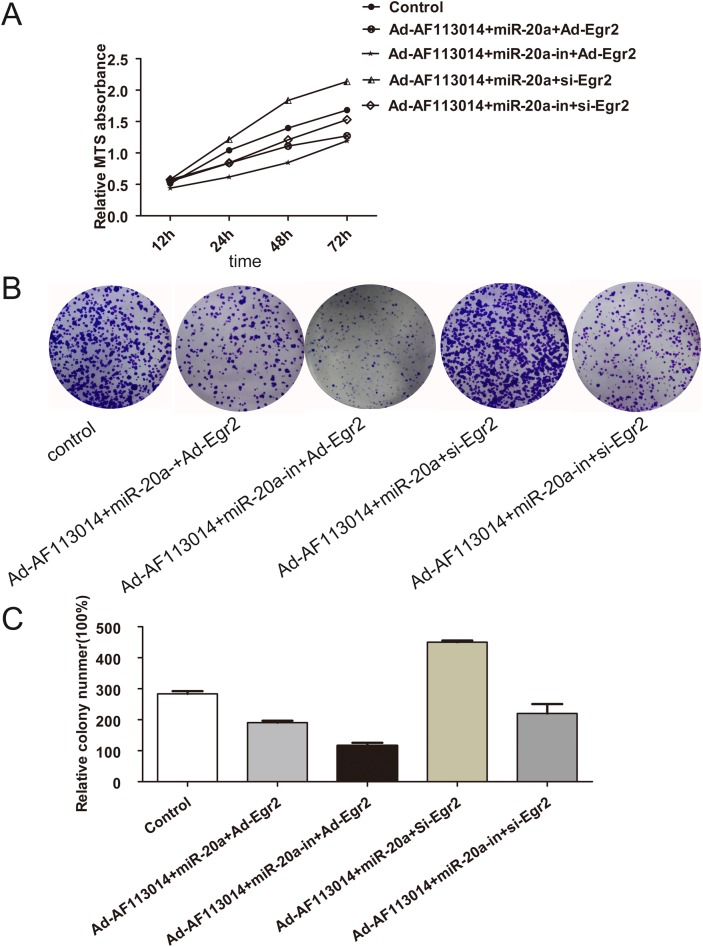
Proliferation founctions of AF113014 effected on miR-20a and Egr2 in HCC cells.(A) Proliferations of SMMC7721 cells were examined by MTS after co-transfected with Ad-AF113014, miR-20a, miR-20a-in, Ad-Egr2, si-Egr2 in groups. (B) Proliferations of SMMC7721 cells were examined by colony formation assay after co-transfected with Ad-AF113014, miR-20a, miR-20a-in, Ad-Egr2, si-Egr2 in groups. (C) Numeralization of (B).